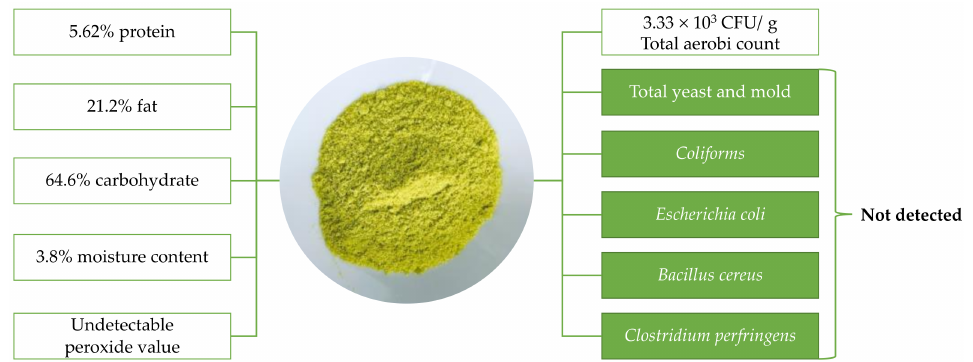
Figure 1. Physicochemical and microbiological properties of avocado powder prepared from avocado flesh ( Persea Americana Mill. cv.